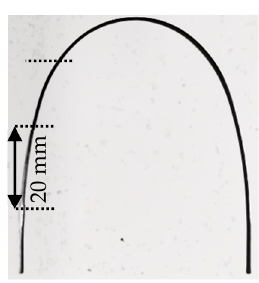
Figure 1. Specimen length of the as-received orthodontic wire.